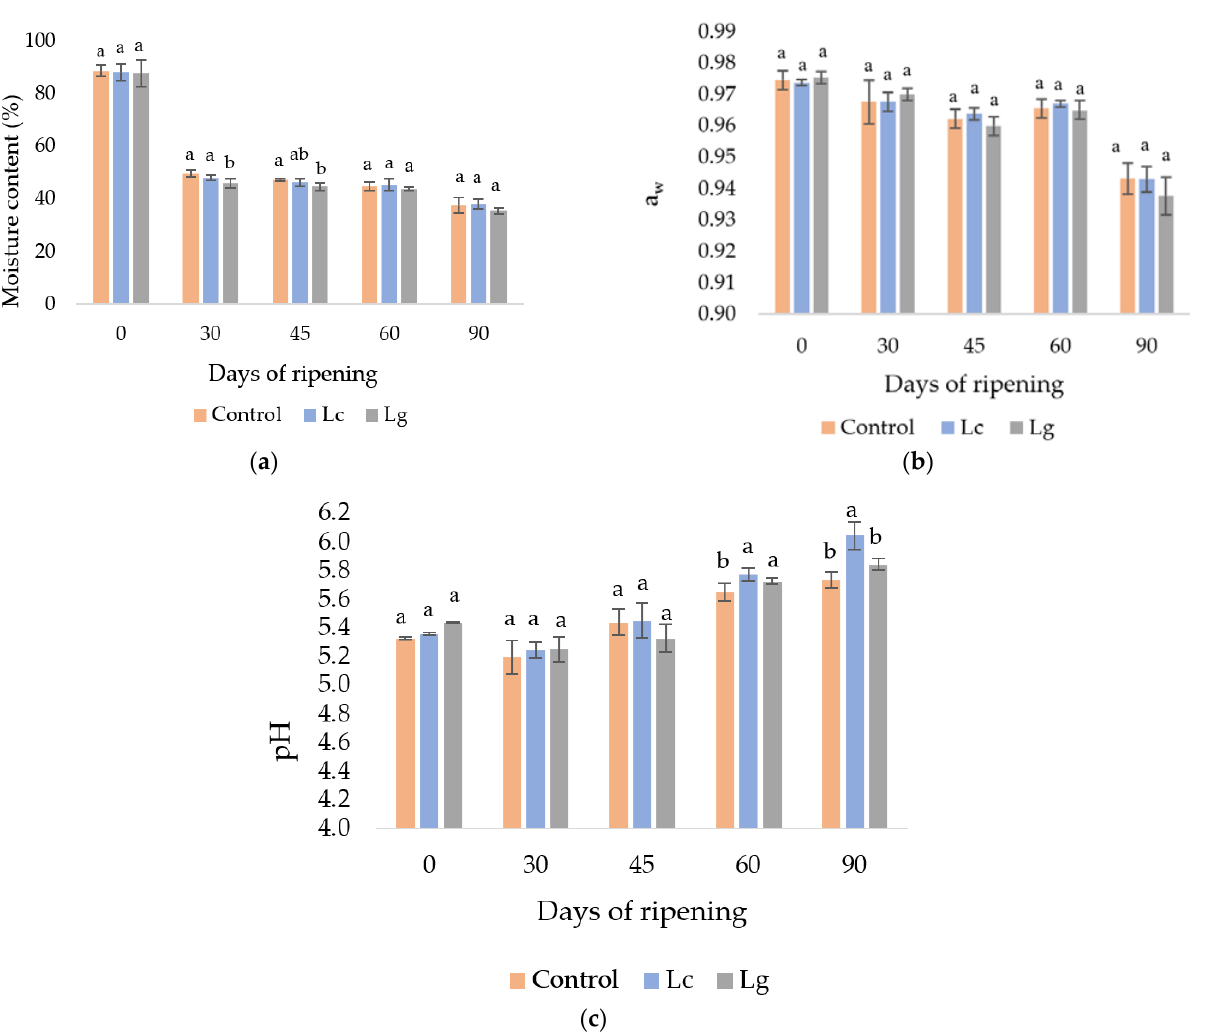
Table 1. Counts of total aerobic microorganism (TAM), lactic-acid bacteria (LAB) and Enterobacteri- acea e (E) throughout “Torta del Casar” cheese ripening. Batches Microorganism